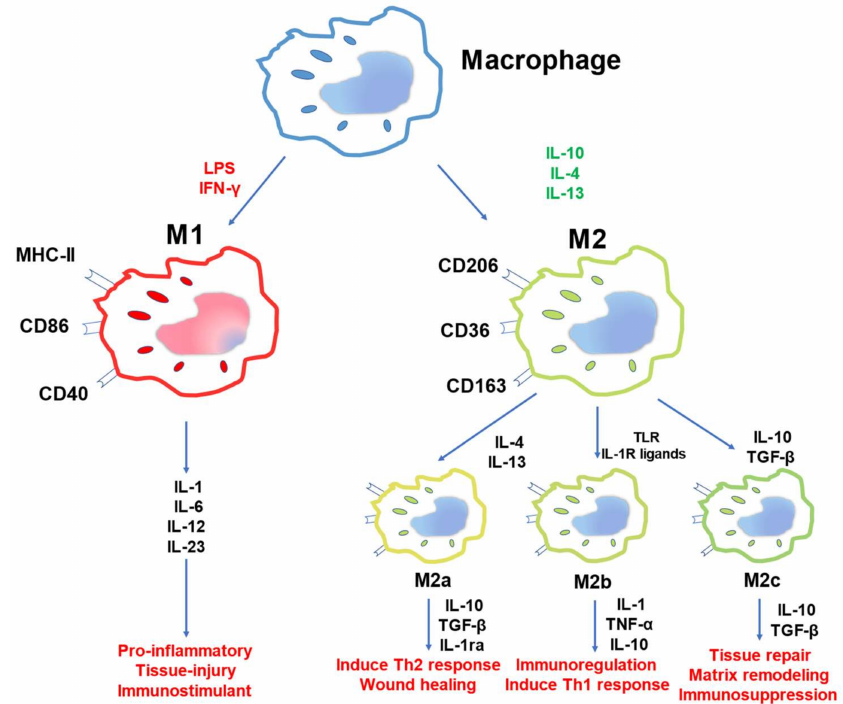
Figure 1. The polarization of macrophages. Inflammatory signals, such as IFN- γ and LPS, can polarize macrophages to the M1 phenotype, which contributes to proinflammation, tissue injury, and immunostimulation. M2 phenotype subsets are polarized by a variety of signals. Currently, M2 macrophages are divided into three categories, M2a, M2b, and M2c, which have immunoregulatory and tissue remodeling